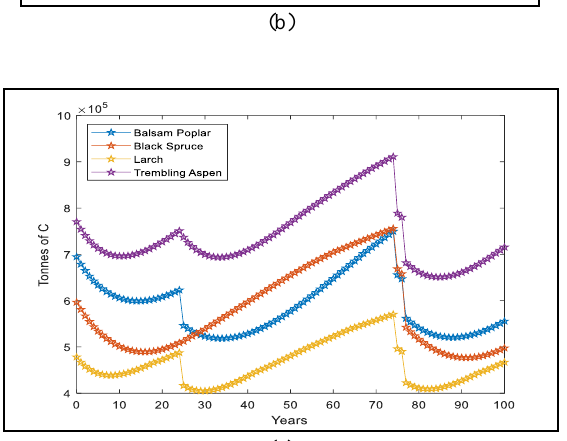
Figure 2: (a) Biomass pool; (b) DOM pool; and (c) Total Ecosystem carbon pool for a four-stand